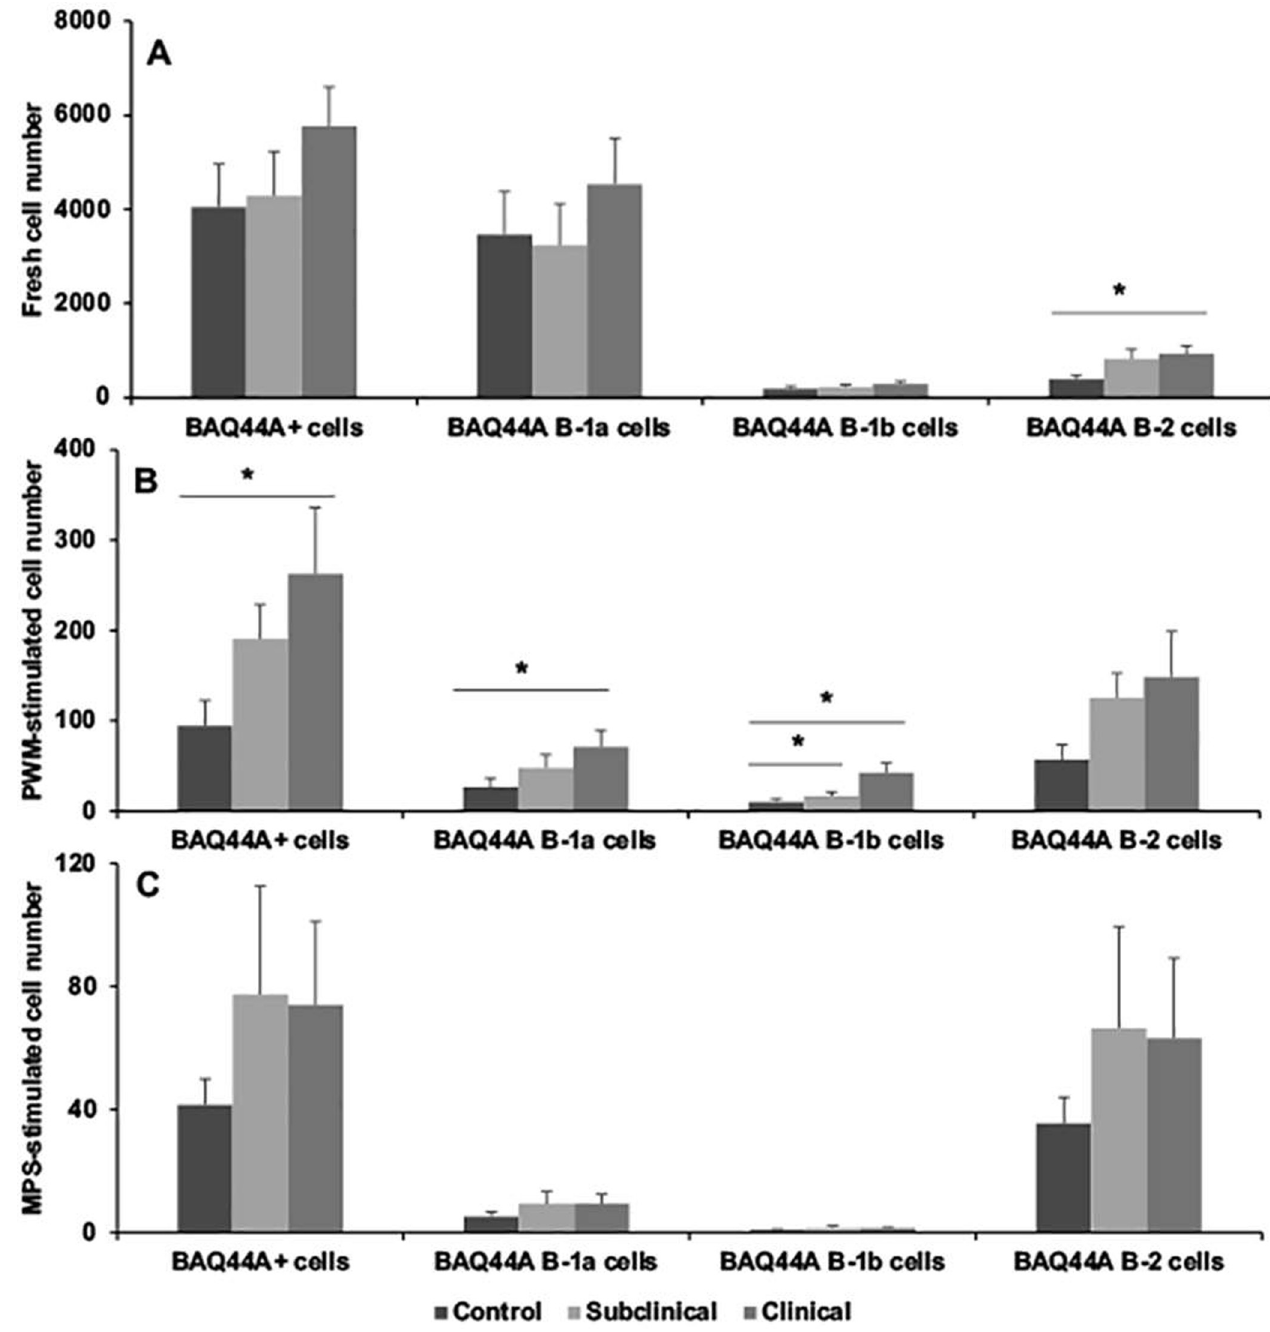
Fig 2. Flow cytometric staining of PBMCs isolated from blood of noninfected control cows and cows naturally infected with M . avium subsp. paratuberculosis using BAQ44A antibody as the primary B cell marker. B cells were further partitioned using CD11b and CD5 antibodies for B cell subpopulations within PBMCs that were freshly isolated (A); incubated with pokeweed mitogen (B; 10 μ g/ml); or with a whole cell sonicate (MPS) of M . avium subsp. paratuberculosis (C; 10 μ g/ml) for 6 days in